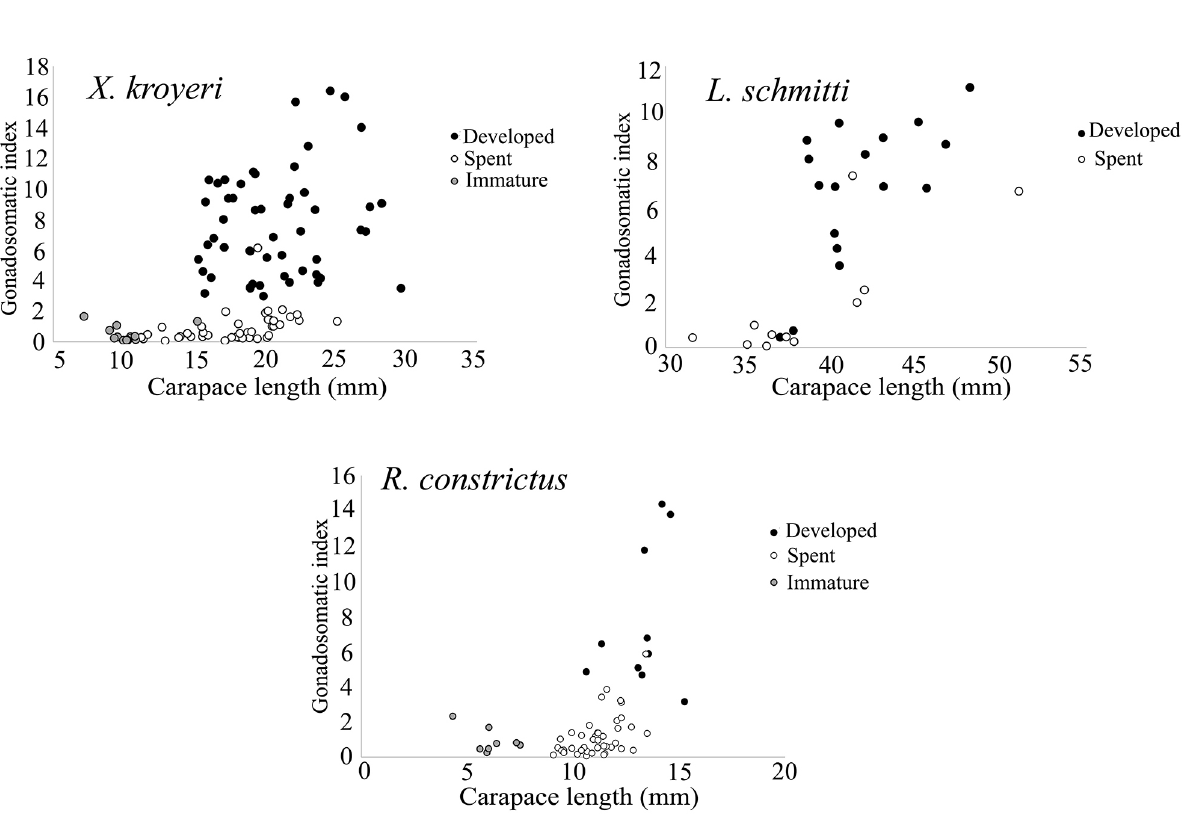
Figure 1. Dispersion graphs of the gonadosomatic index separated by gonad development stage and size of the individual for each species studied: seabob shrimp ( Xiphopenaeus kroyeri ) , white shrimp ( Litopenaeus schmitti ) and roughneck shrimp ( Rimapenaeus constrictus